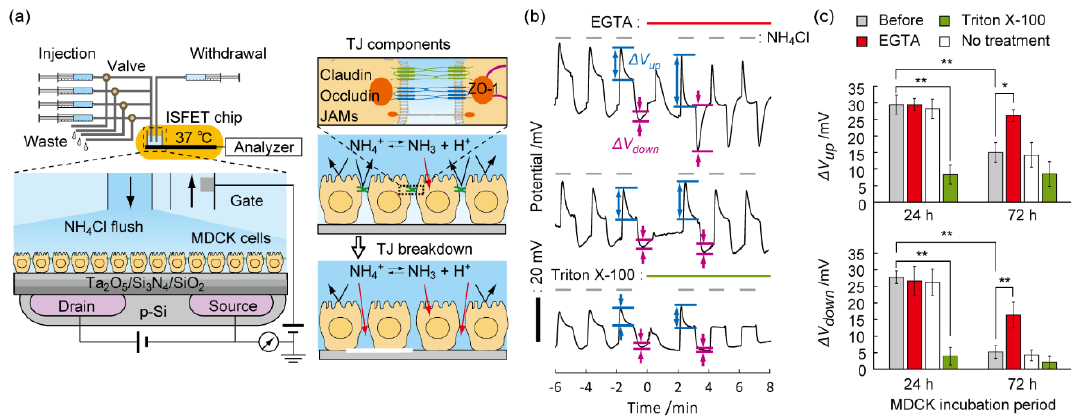
Figure 6. Analysis of barrier functions of epithelial cells with TJs by a pH perturbation assay. ( a ) Schematic diagram showing a system combining ISFET and automated fluidics. Ions permeate cell gaps as a result of TJ breakdown. TJ is mainly composed of claudin, occludin, JAMs, and ZO-1. ( b ) Time course of the gate potential in MDCK cell cultures at 72 h during the NH 4 Cl-induced pH perturbation assay with/without exposure to 1 mM EGTA or 1 mg/mL Triton X-100. ( c ) Δ V up and Δ V down of MDCK cells cultured for 24 h or 72 h following treatment with EGTA or Triton X-100. Mean ± SD ( n = 3). * p < 0.05, ** p < 0.01. Reproduced with modification from [86] with permission by the American Chemical Society.